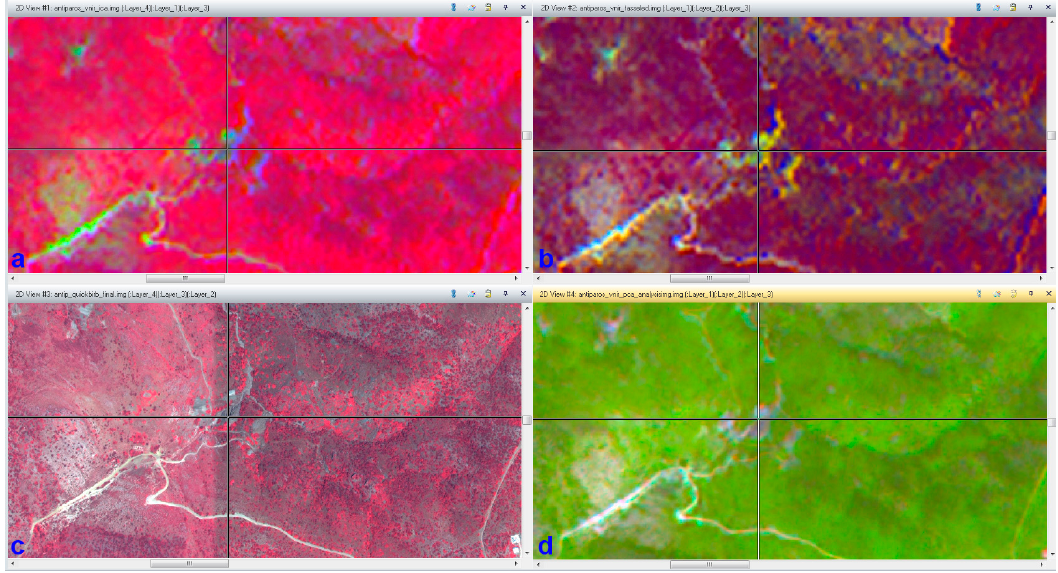
Figure 4. Detection of talus cones in area 5. They can be detected with blue color in the ALOS VNIR ICA image ( a ) and with green color in ALOS VNIR Tasseld Cap image ( b ) The same area is presented in a 432 RGB combination of the Quickbird image in ( c ) and with brown color in the ALOS VNIR PCA image ( d ).